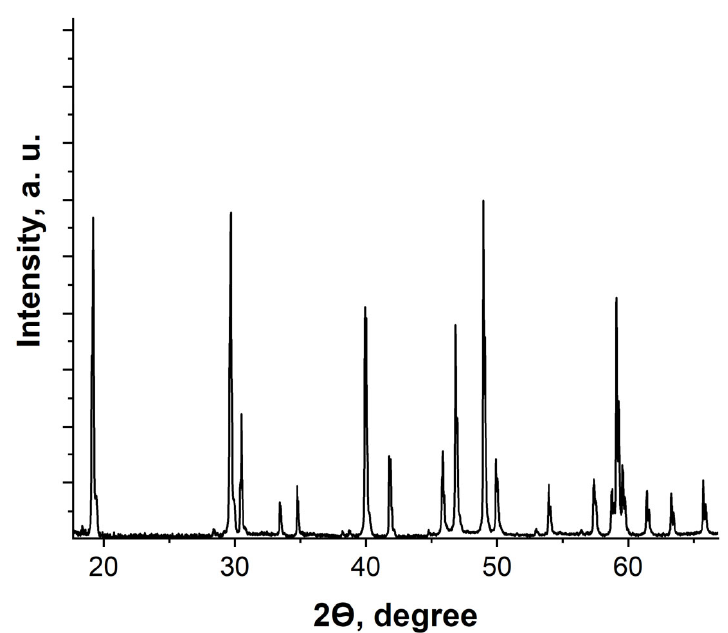
Figure 1. XRD patterns of Nd 3+ (0.3%), Yb 3+ (2.0%): LiYF 4 phosphors.